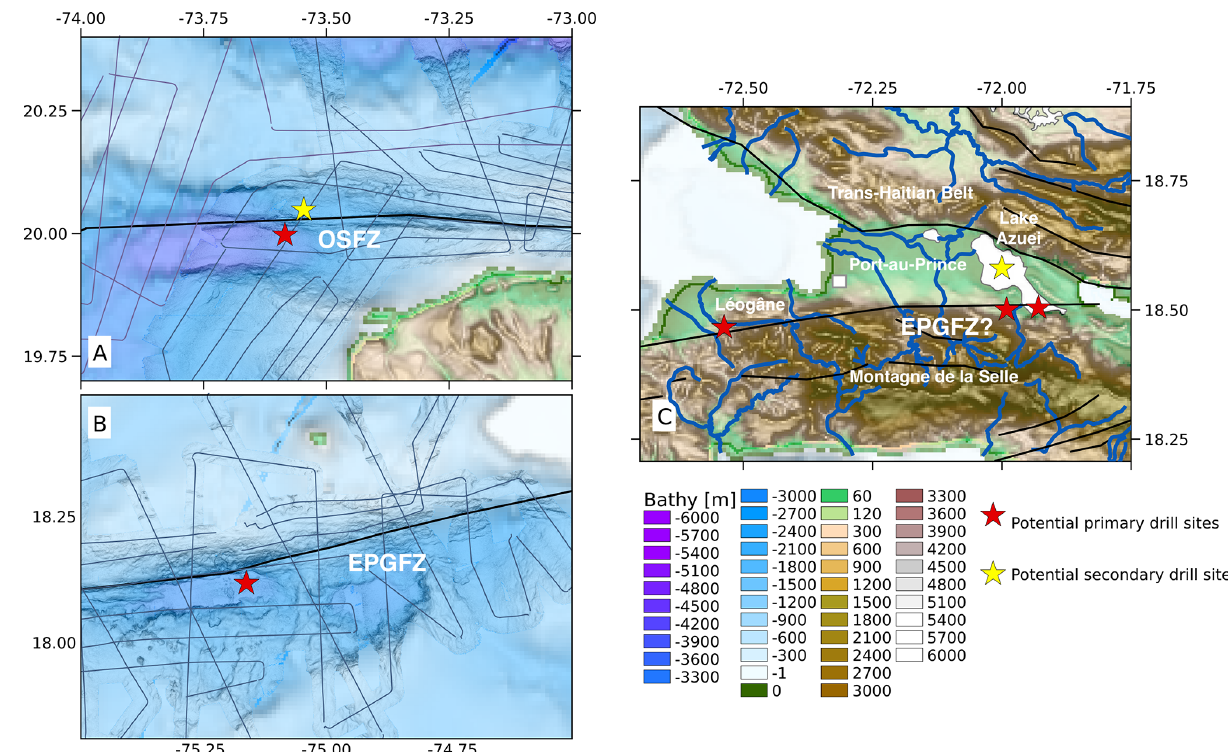
Figure 4. Potential drilling sites (red stars) and alternates (yellow stars). (a) In a basin of the Windward Passage along the OSFZ offshore the northern Haitian peninsula, (b) in the Navassa Basin of the Jamaica Passage along the EPGFZ offshore the southern Haiti peninsula and (c) onshore near the EPGFZ terminus – one site on land and one site in Lake Azuei. At the potential Momance River site, west of Port-au- Prince near the Léogâne delta plain, the fault trace is better defined and the fault is also more vertical. To the east, less is known. The trace of the EPGFZ terminus east of Port-au-Prince, while illustrated in panel (c) , is actually unknown, and the fault possibly dips south-southwest. The site near the Léogâne delta plain requires less additional survey work and is preferred but difficult to link scientifically to the Lake Azuei site. Multichannel seismic (MCS) data were acquired during Haiti-SIS and Haiti-SIS2 along the ship tracks, as shown in panels (a) and (b)